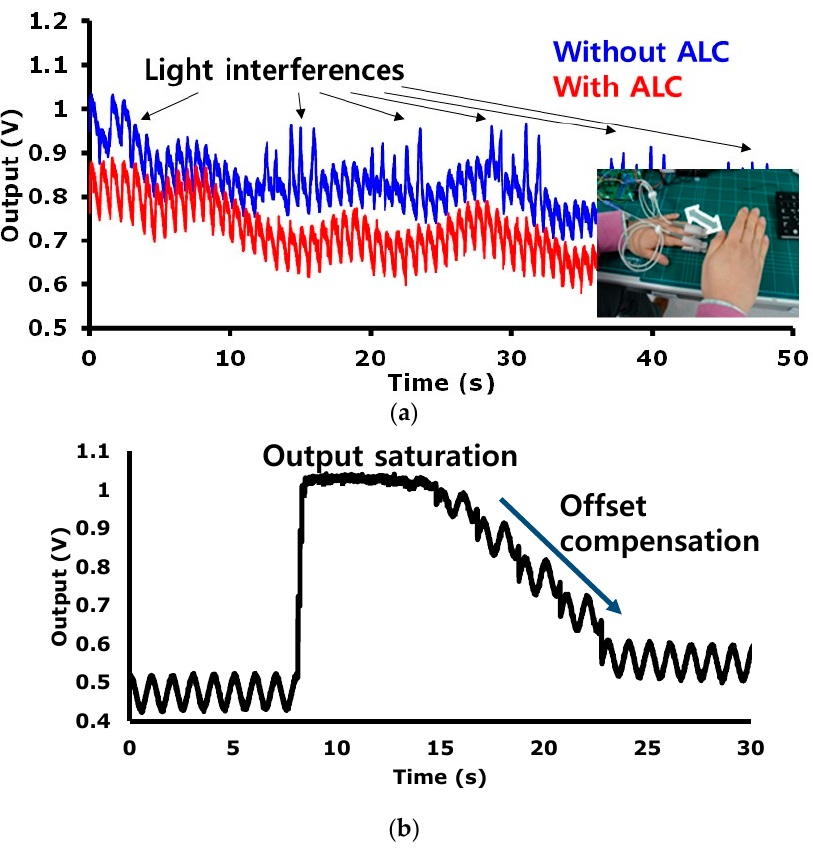
Figure 14. Measurement results in the PE sensing mode; ( a ) photoplethysmography (PPG) signals compared with/without the ambient light cancellation (ALC) function, according to the ambient light noise application; ( b ) Restoration of the saturated signal by the automatic offset compensation (AOC).